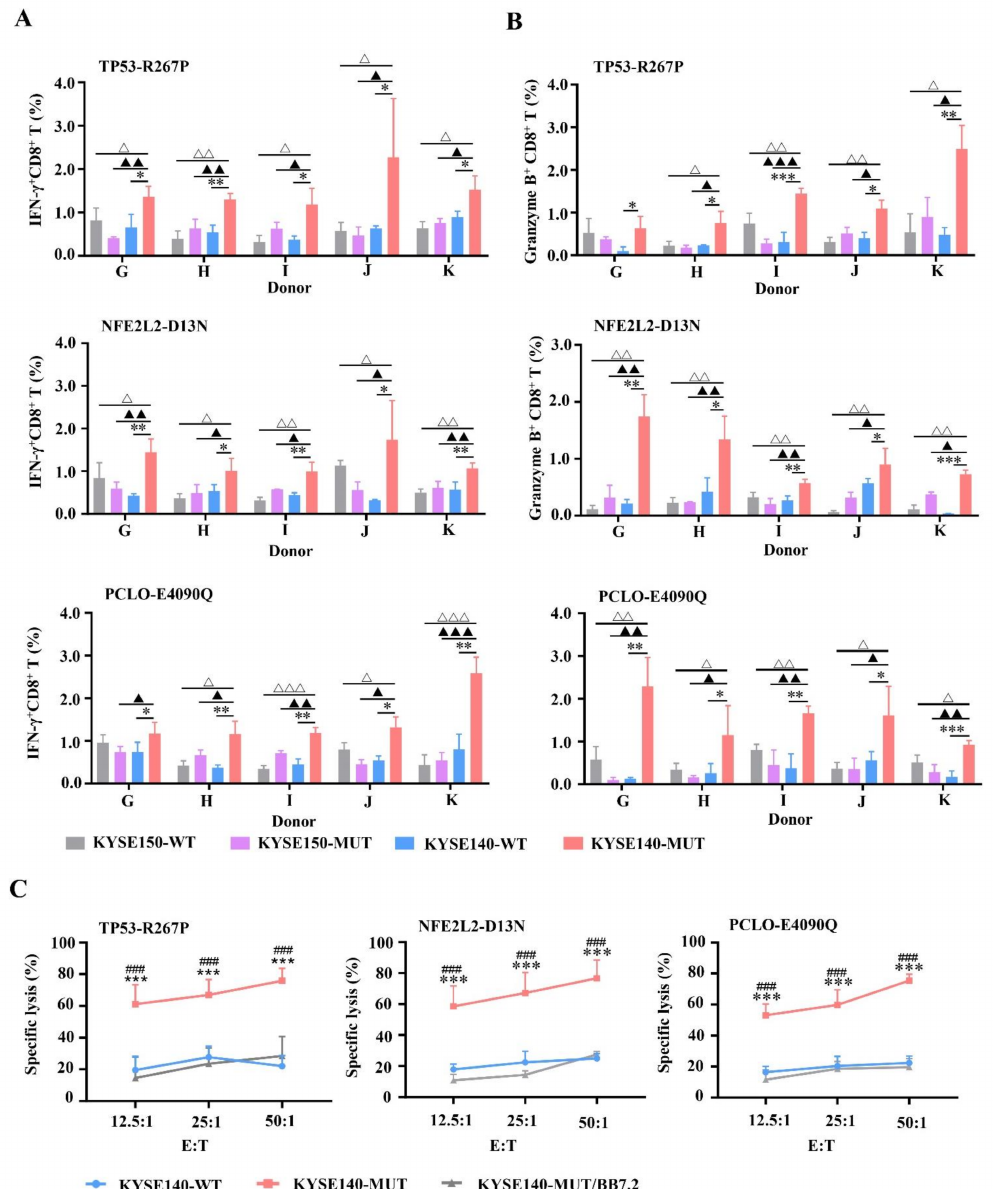
Figure 2. The IFN- γ release and KYSE tumor cell lines lysis of MUT peptide-induced T cells in vitro. PBMCs isolated from five healthy HLA-A2 + donors (donors G–K) were induced by mature DCs pulsed by MUT peptides P53-R267P, NFE2L2-D13N, or PCLO-E4090Q (10 µ g/mL), respectively, once a week for three weeks. Two minigenes that encoded these three MUT peptides or their corresponding WT peptides were constructed and transfected individually into tumor cell lines KYSE140 (HLA-A2 + ) or KYSE150 (HLA-A2 − ). Transfected cells KYSE140-WT (HLA-A2 + , MUT peptide − ), KYSE140-MUT (HLA-A2 + , MUT peptide + ), KYSE150-WT (HLA-A2 − , MUT peptide − ), and KYSE150-MUT (HLA-A2 − , MUT peptide + ) were served as target cells to detect CTL response via IFN- γ secretion and granzyme B expression in the intracellular cytokine assay (( A , B ), n = 3, three duplicate samples of each donor). The target cells in cytotoxicity assay are KYSE140-WT, KYSE140-MUT, and KYSE140-MUT/BB7.2 (( C ), n = 5). Statistical significance was determined by Student’s t -test. In IFN- γ secretion and granzyme B expression assay, * p < 0.05, ** p < 0.01, *** p < 0.001 represented the significance of KYSE140-MUT (cid:78) p (cid:78)(cid:78) p (cid:78)(cid:78)(cid:78) p group versus KYSE140-WT group; < 0.05, < 0.01, < 0.001 represented the significance of KYSE140-MUT group versus KYSE150-MUT group; (cid:52) p < 0.05, (cid:52)(cid:52) p < 0.01, (cid:52)(cid:52)(cid:52) p < 0.001 represented the significance of KYSE140-MUT group versus KYSE150-WT group. In lysis cytotoxicity assay, ### p < 0.001 represented the significance of KYSE140-MUT group versus KYSE140-MUT/BB7.2 group; *** p < 0.001 represented the significance of KYSE140-MUT group versus KYSE140-WT